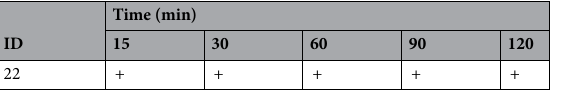
Table 3. Proteolysis resistance for alginate lyase (ID 22) at a concentration of 0.83 g/L, when subjected to the proteolytic action of pancreatin, which was incubated at a final concentration of 2.5 g/L. The reactions were incubated at 37 ºC, at regular intervals of 15 min for 120 min. Results are presented at periods of 15, 30, 60, 90 and 120 min of incubation. The qualitative scale of proteolysis resistance is based on SDS-PAGE gels visualisation: -, no resistant (only fragmentation bands); + , partially resistant (protein and fragmentation bands).